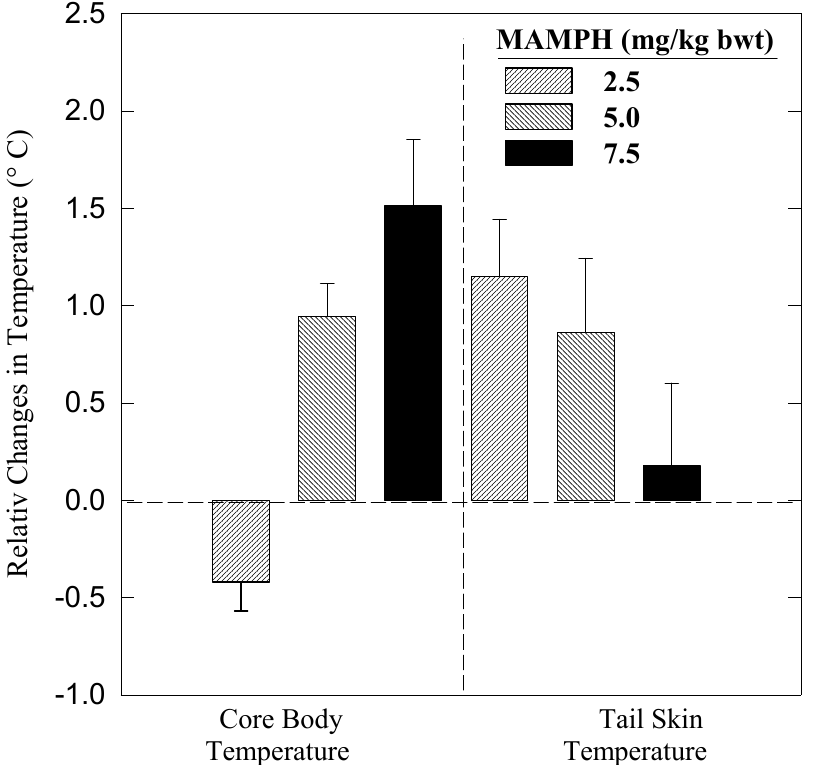
Figure 2. Effects of methamphetamine on core body and tail skin temperature one hour after drug injection at 21 ±